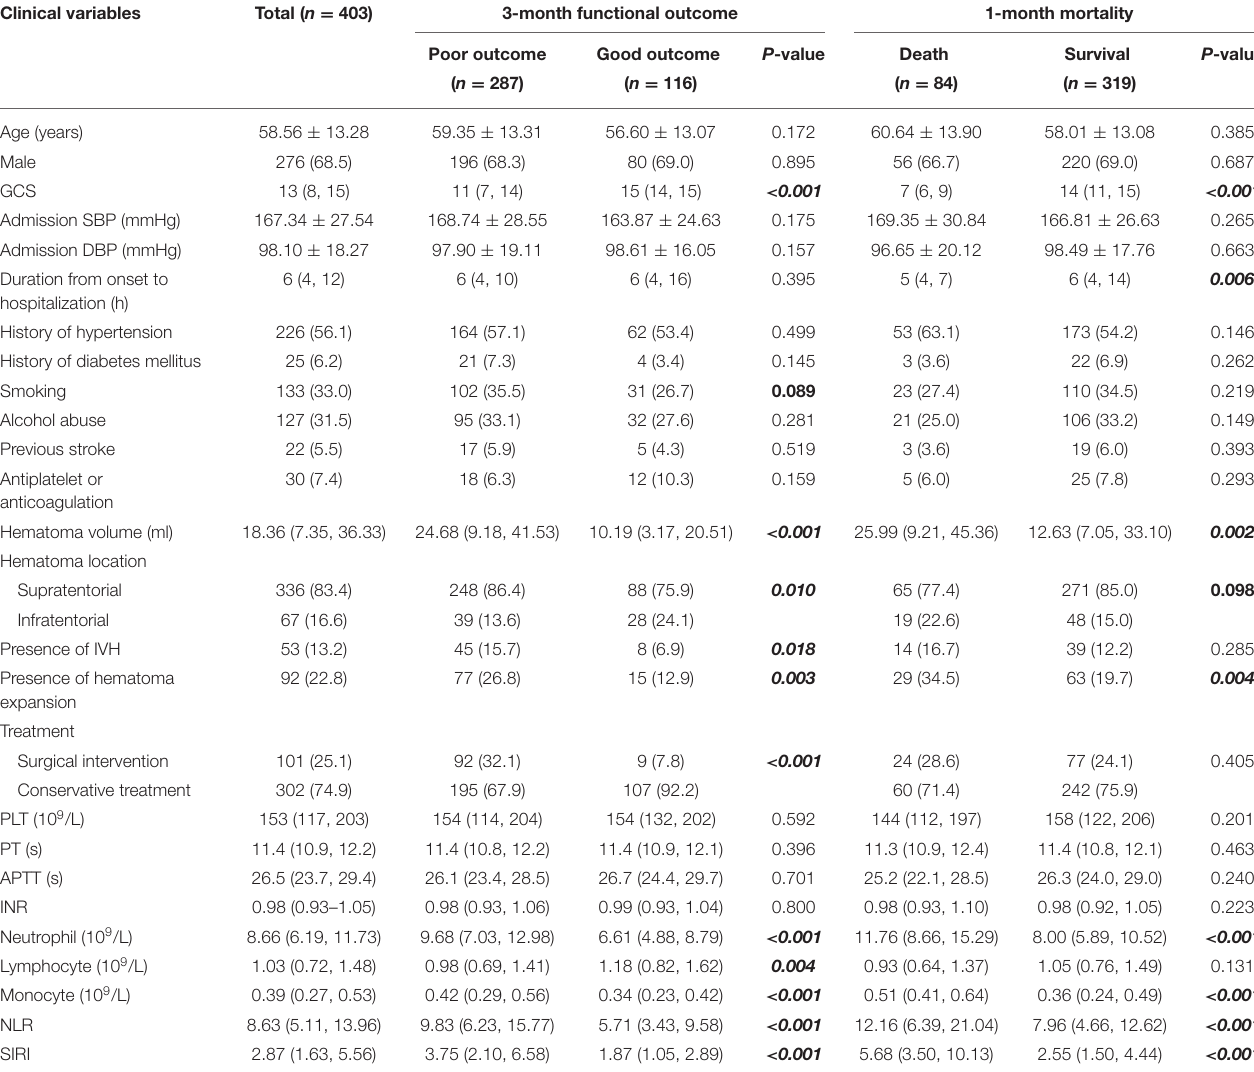
TABLE 1 | Baseline characteristics of 403 patients with spontaneous ICH in original cohort. Clinical